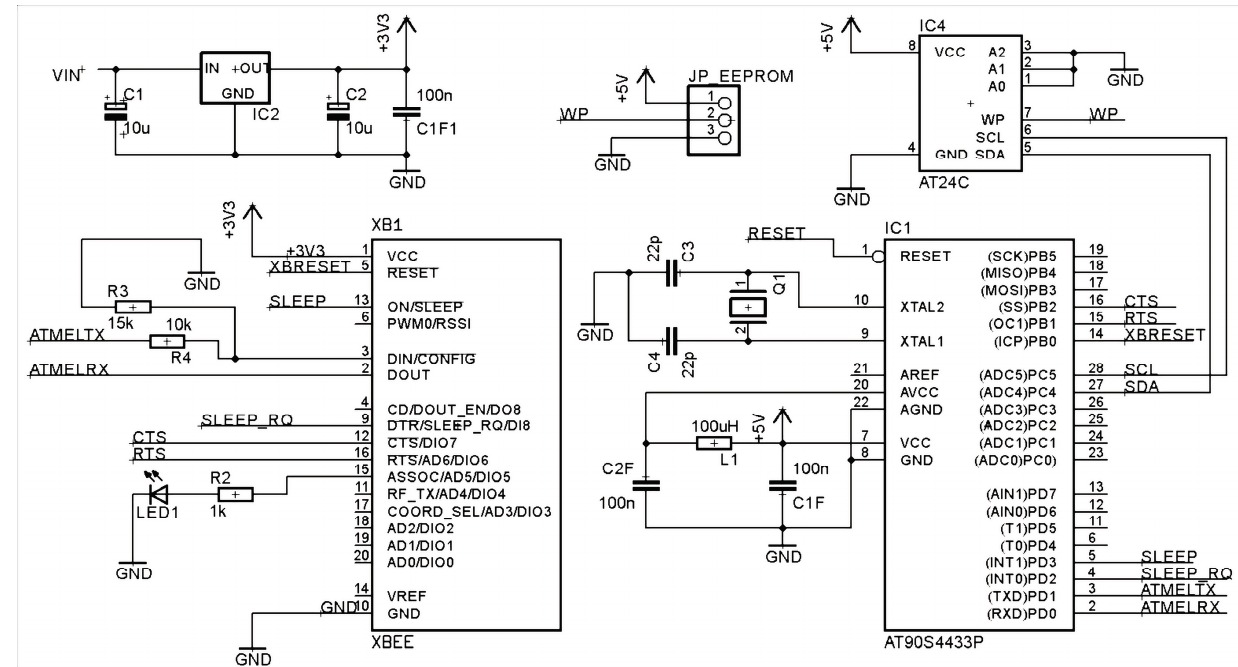
Figure 4. Wireless Schematic Final